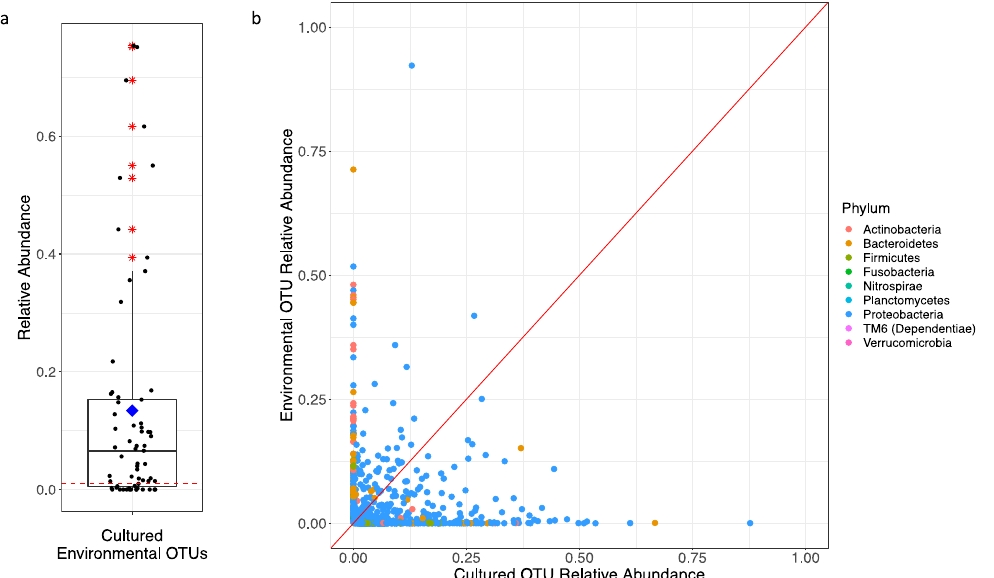
Figure 8. ( a ) Boxplot representing the relative abundance of OTUs also found among the culturable communities from each environmental sample. Outliers are indicated by “*” and the mean relative abundance for all samples is indicated by “ ♦ ” where the average abundance was 13.4%. ( b ) Relative abundances each culturable OTU between environmental and cultured communities. Each OTU is assigned a color based on the phyla that OTU was assigned to. The red line is the identity line representing equal abundance between sequencing approaches (Environmental = Cultured).